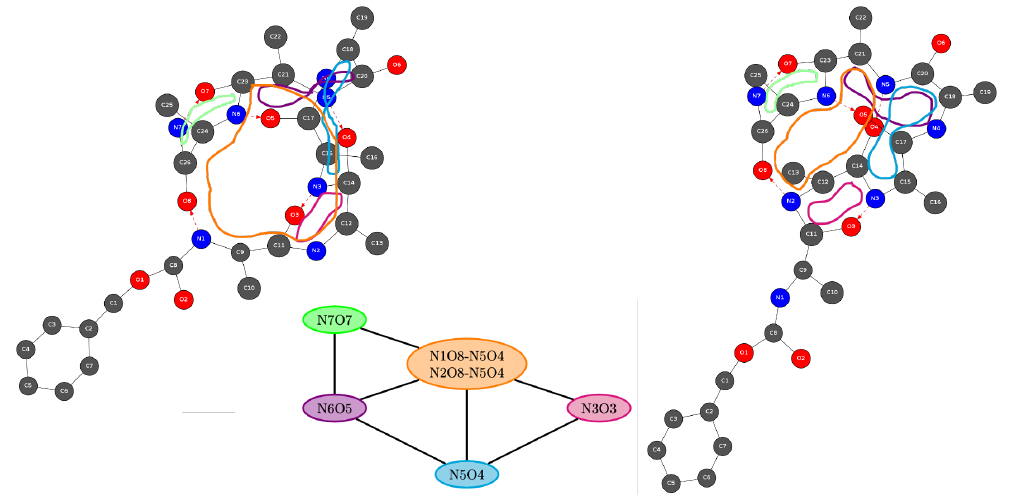
Figure 6. Example of two 2D-MolGraphs of two conformers of gas phase Z − Ala 6 − COOH (C 26 H 39 N 7 O 8 ) peptide. The five H-bonded rings/cycles that exist in each conformation have been highlighted in different colors (orange, green, purple, light blue, pink). The bottom graph is the coarse-grained graph of cycles that is identical for the two conformers. The colors used for the vertices of the graph of cycles are identical to the colors used in the 2D-MolGraphs for representing the H-bonded cycles. See text for more details on the graph of cycles, in particular for the definitions of the